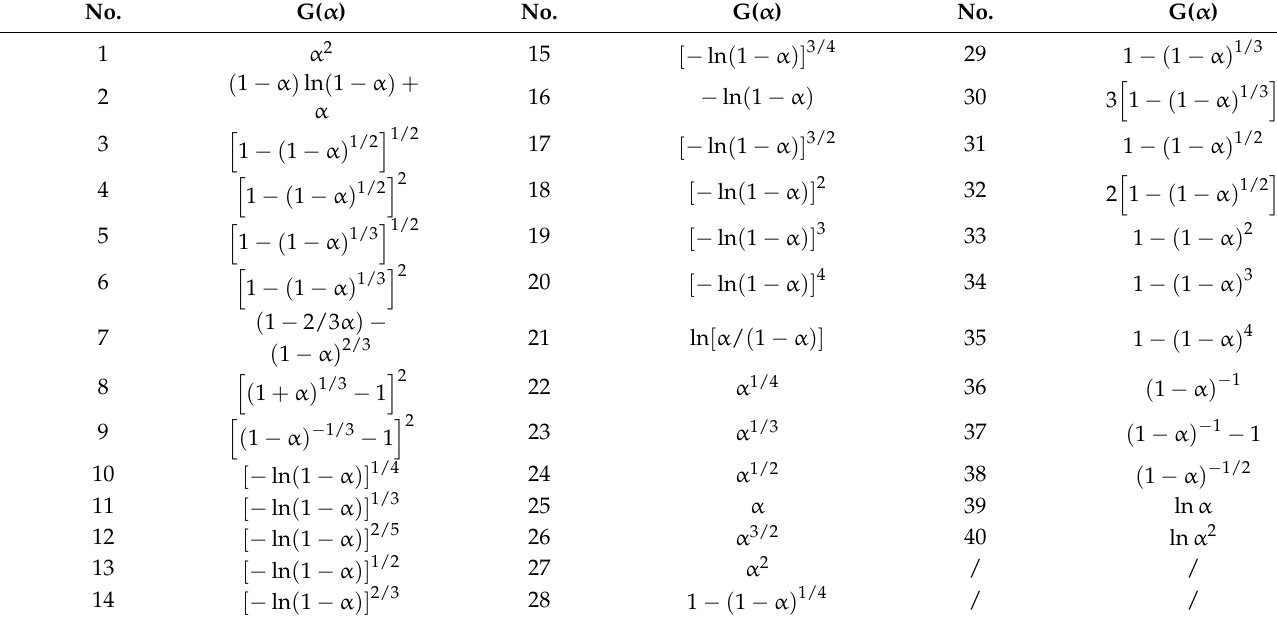
Table 2. Commonly used thermal decomposition reaction mechanism